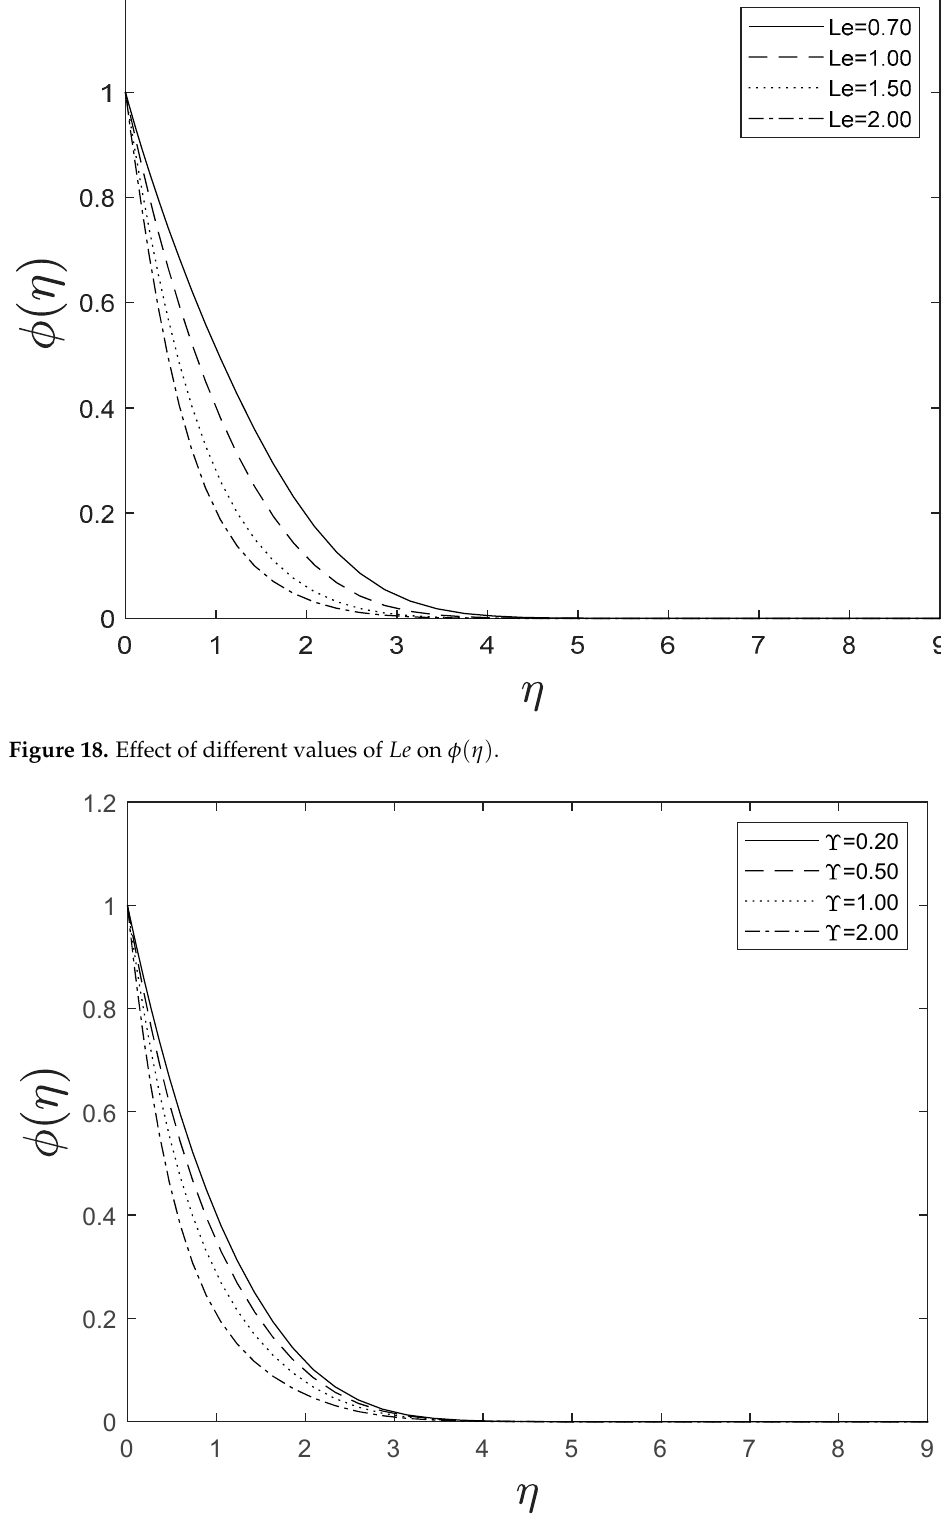
( ) φ η γ ( ) φη γ on . on .